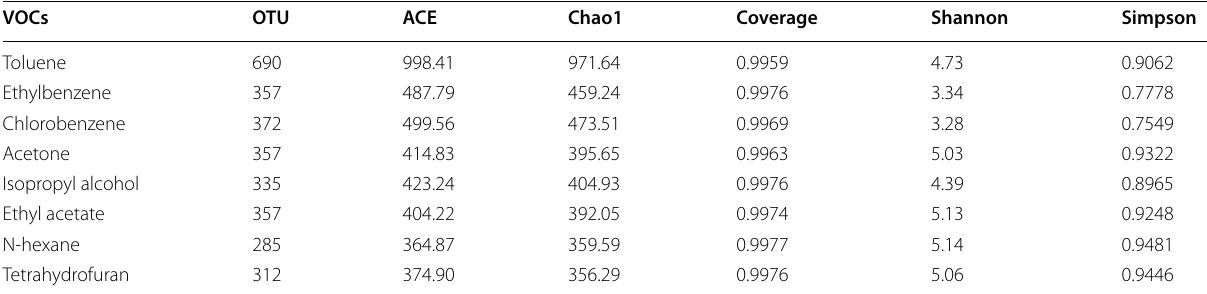
Table 2 Indexes of microbial following treatment with different types of VOCs VOCs OTU ACE Chao1 Coverage Shannon